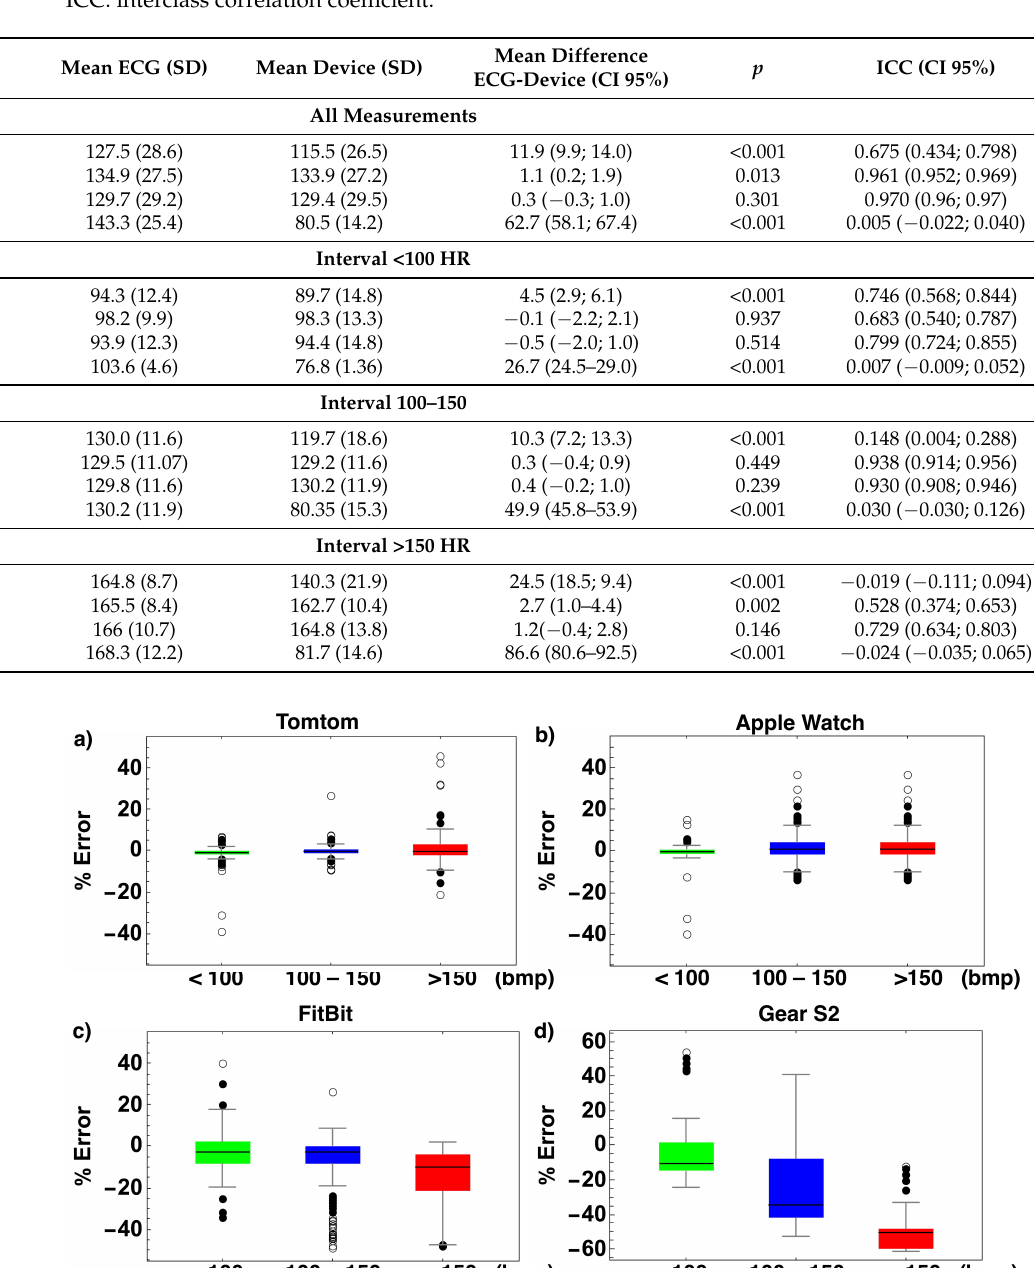
Table 2. Paired mean difference (ECG vs. device) and accuracy in the whole sample and stratified by HR range. SD: standard deviation; CI: confidence interval; HR: heart rate; ECG: electrocardiography; ICC: interclass correlation coefficient.